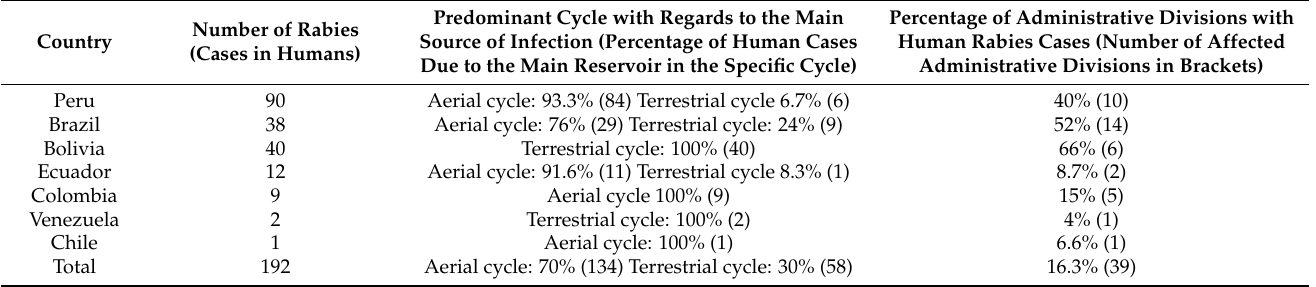
Table 4. Number of human cases reported during the period of study, main source of infection in reported cases (aerial or terrestrial) and percentage of administrative divisions reporting rabies cases by country.